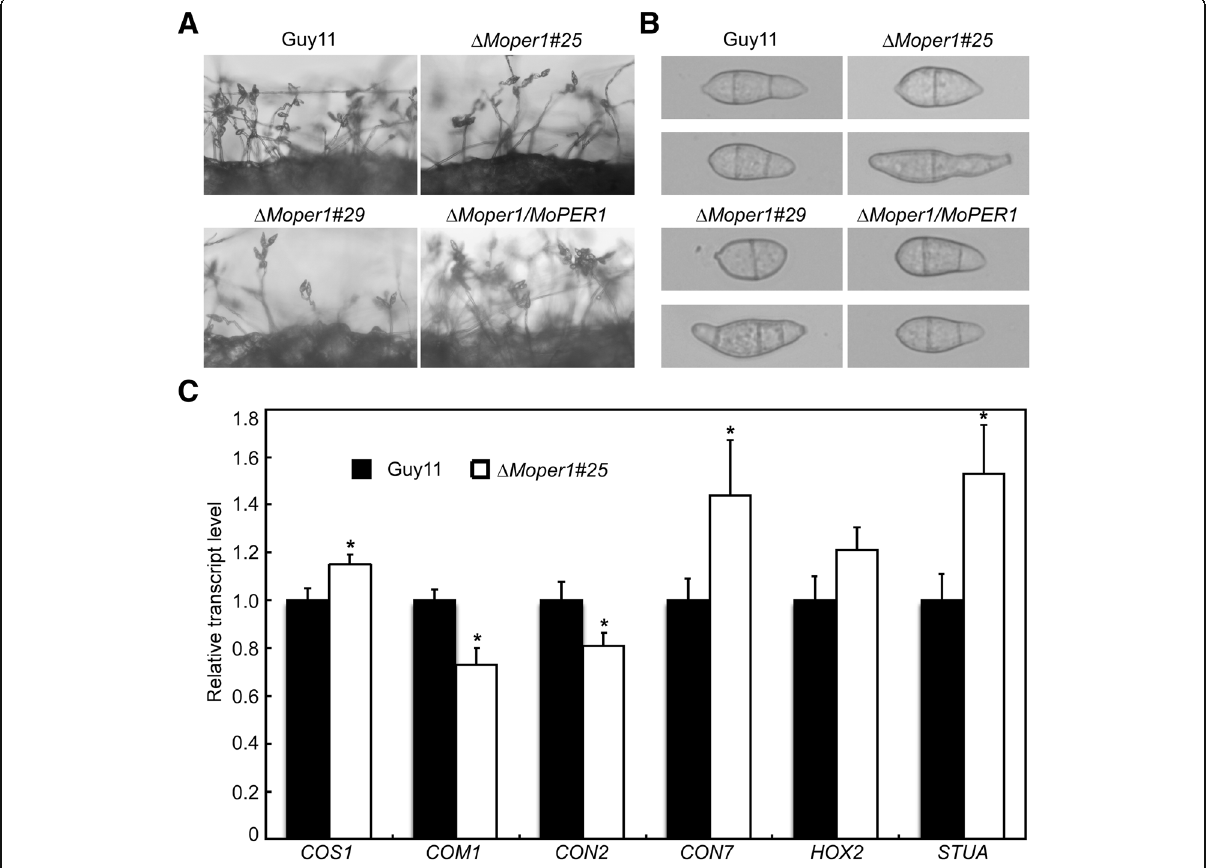
Fig. 5 MoPer1 is required for normal conidia formation. a Conidia formation was observed under a light microscope 24 h at room temperature after induction of conidiation under cover slips. b Morphological observations of conidia. c Expression analysis of conidiation-related genes by qRT-PCR in the Δ Moper1 mutant. Asterisks represent significant differences ( p <